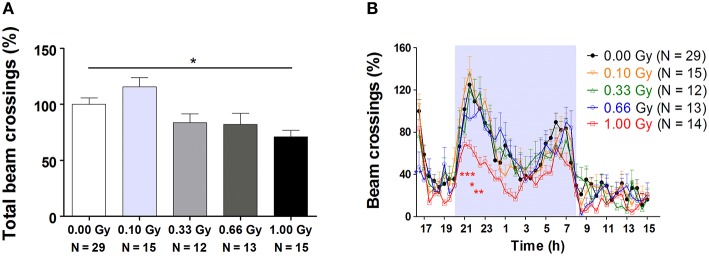
Decreased 23-h spontaneous cage activity, with the conservation of the circadian rhythm, is observed in prenatally high-dose exposed mice. (A) Animals irradiated with 1.00 Gy at E11 displayed a decreased activity, as assessed by the total amount of beam crossings during a 23-h period. (B) Examination of the circadian profile of all animals indicated a decline in beam crossings during the dark phase in high-dose exposed mice. Data are presented as mean ± SEM. Horizontal lines with an asterisks indicate significant differences between means of two groups. *P < 0.05, **P < 0.01, ***P < 0.001. The number of animals used is indicated in the graphs (N). E, embryonic day; Gy, Gray.